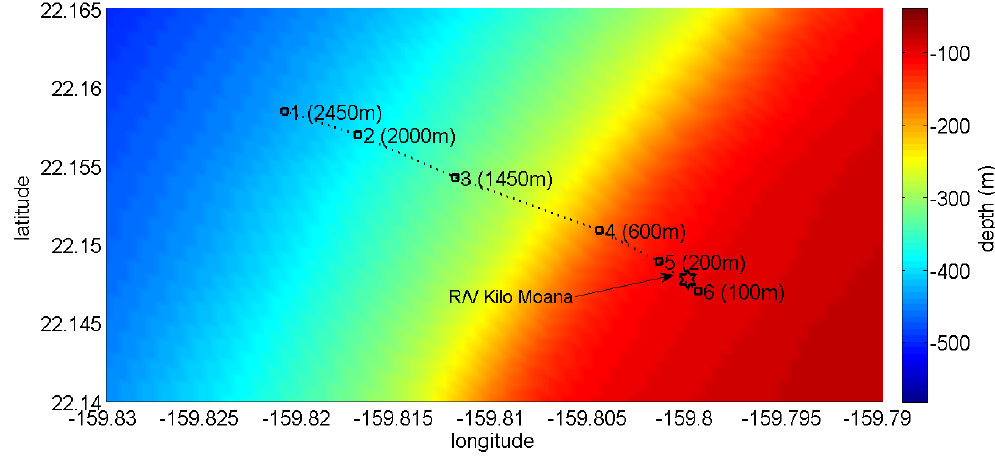
Figure 6. Bathymetry of the Makai’05 experimental area for the field calibration event with the superimposed research vessel R/V Kilo Moana location (pentagon) and GPS fixes of the source rubber boat (square). The values in brackets represent the distance to the R/V Kilo